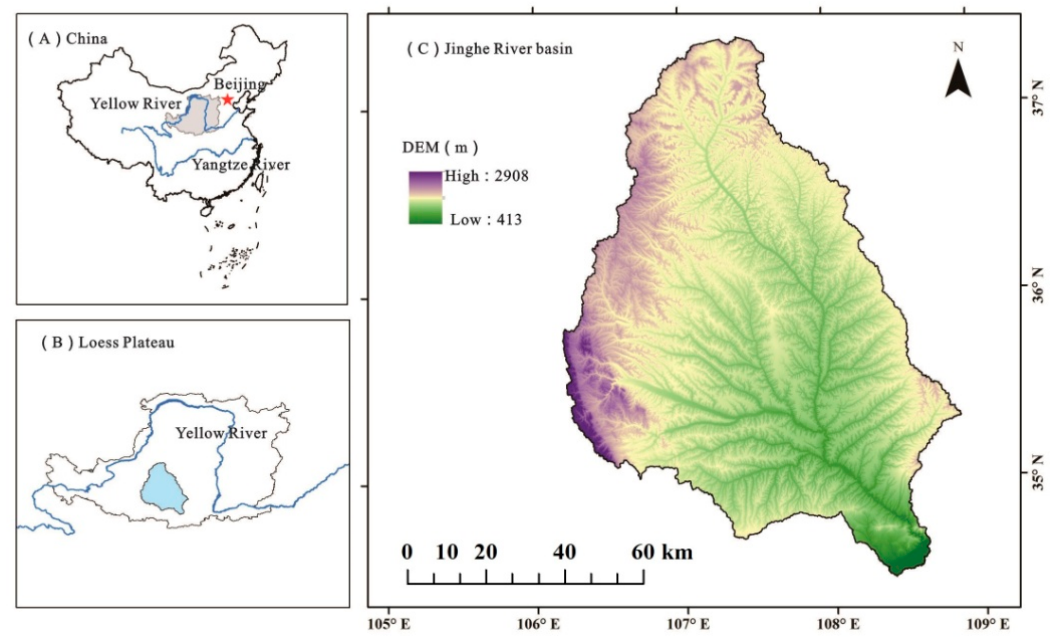
Figure 1. Location of the Jinghe River basin. DEM, Digital Elevation Model.